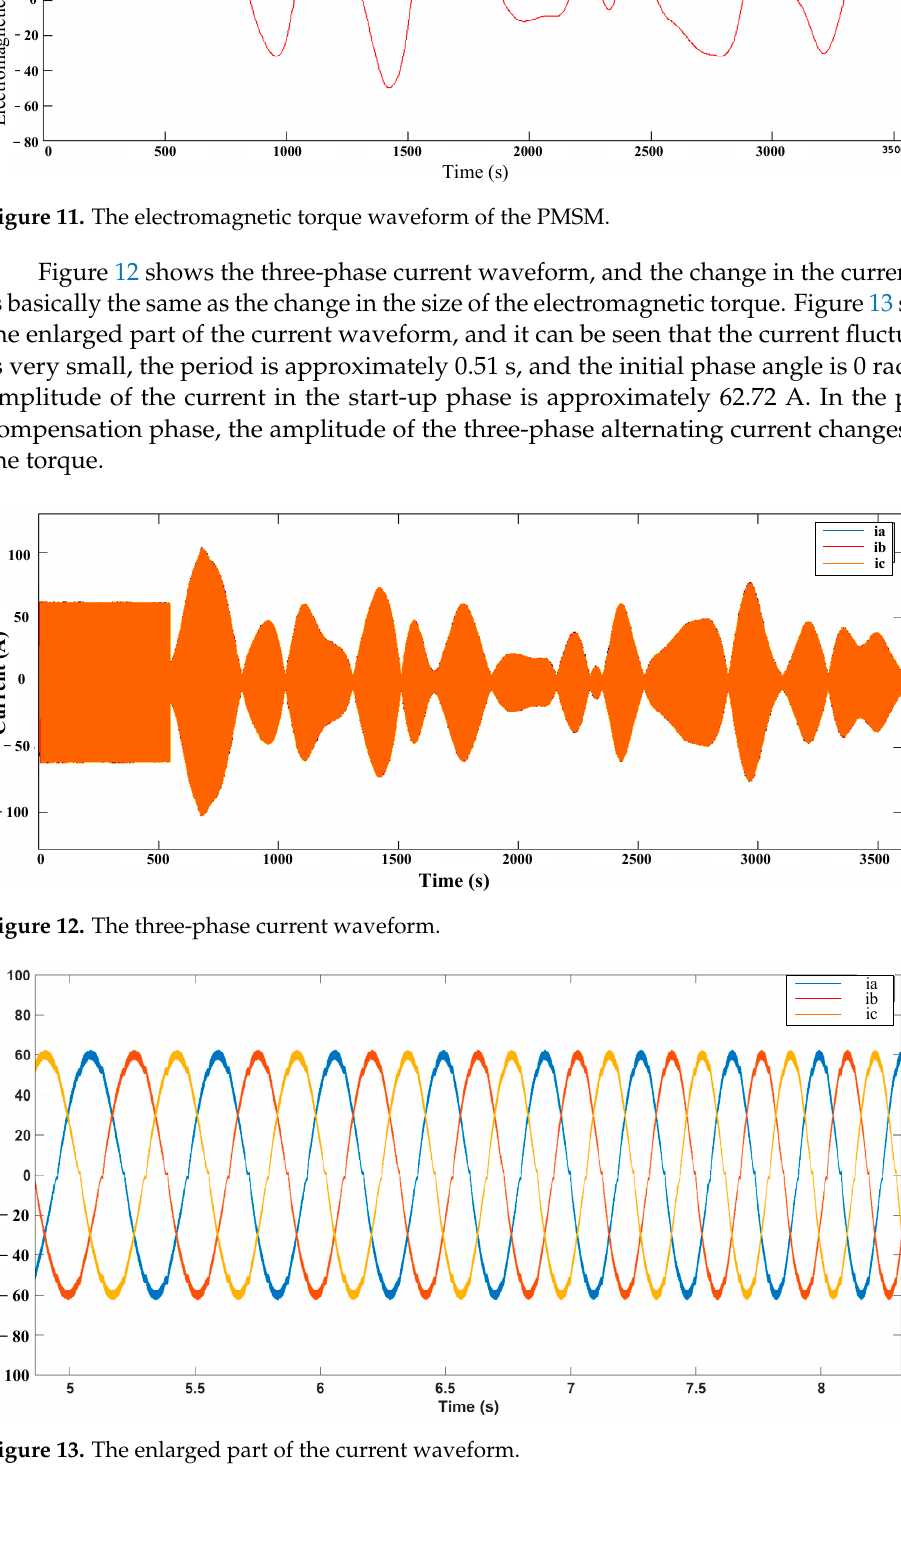
Figure 10. The enlarged part of the speed waveform.